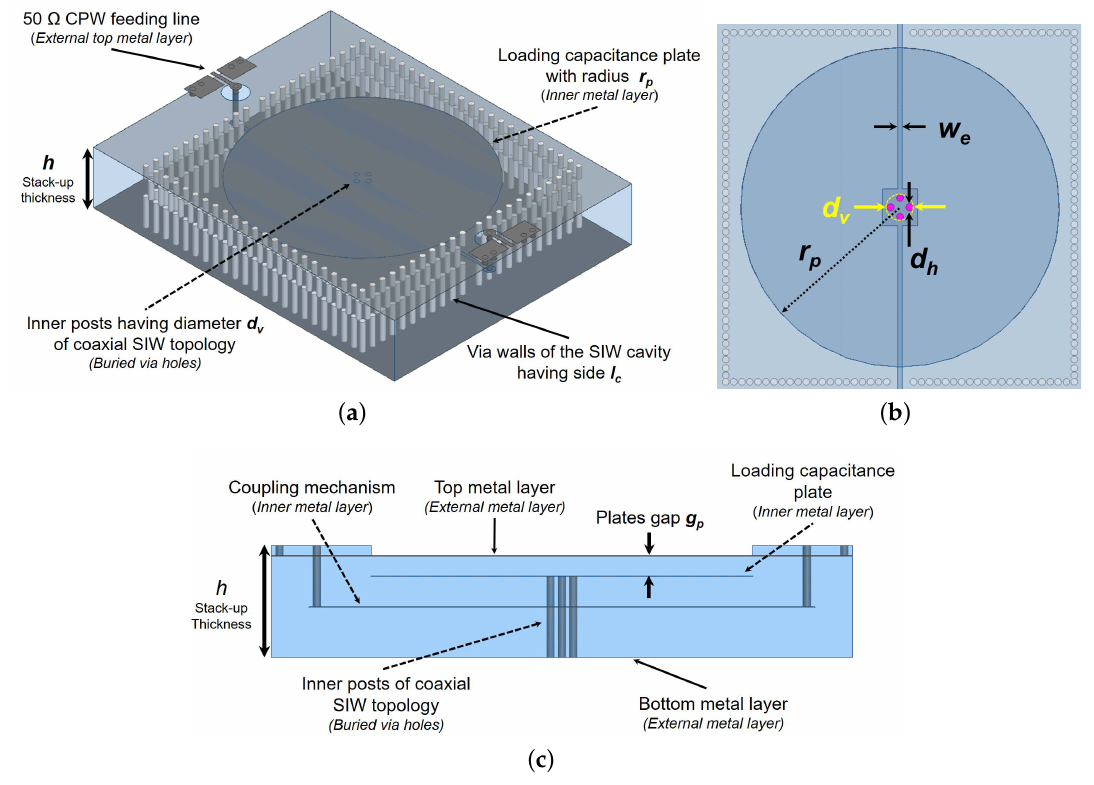
Figure 1. 3D sketches of an embedded CSIW resonator including main dimensions: ( a ) top view; ( b ) detail of the inner conductor and capacitive plate; and ( c ) lateral view.